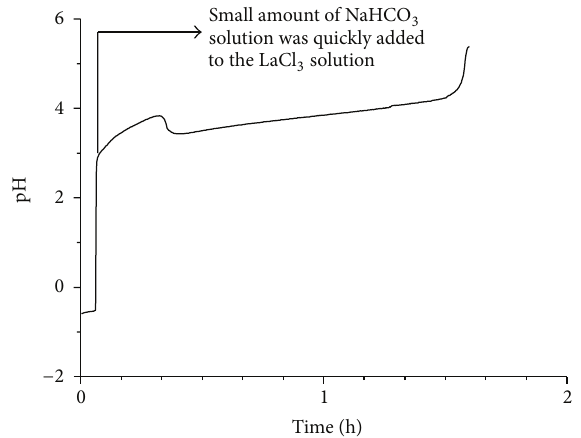
Figure 1: Variation of pH value as a function of time when NaHCO 3 solution is added to LaCl 3 solution at a rate of 0.2